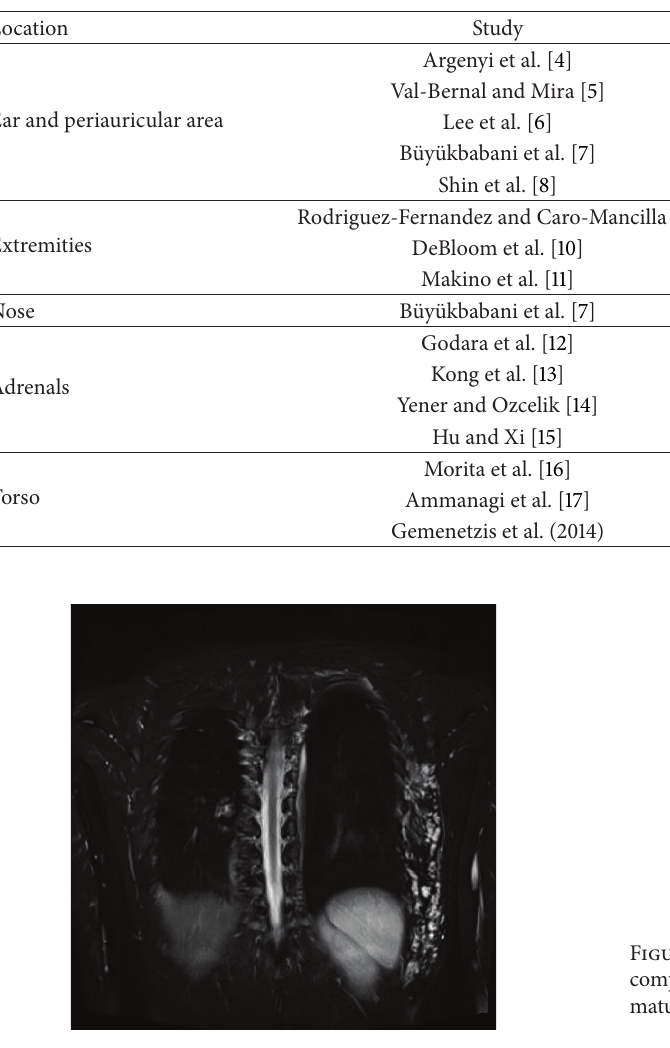
Figure 1: MRI scan (coronal view) of the lesion, which is located under the left scapula and extending posterolaterally down to the rim of the left 10th rib.